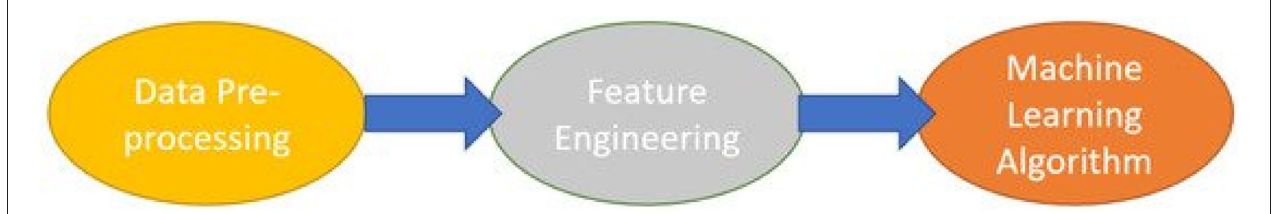
FIGURE 3 | Flow chart for data processing to estimate hydration level.